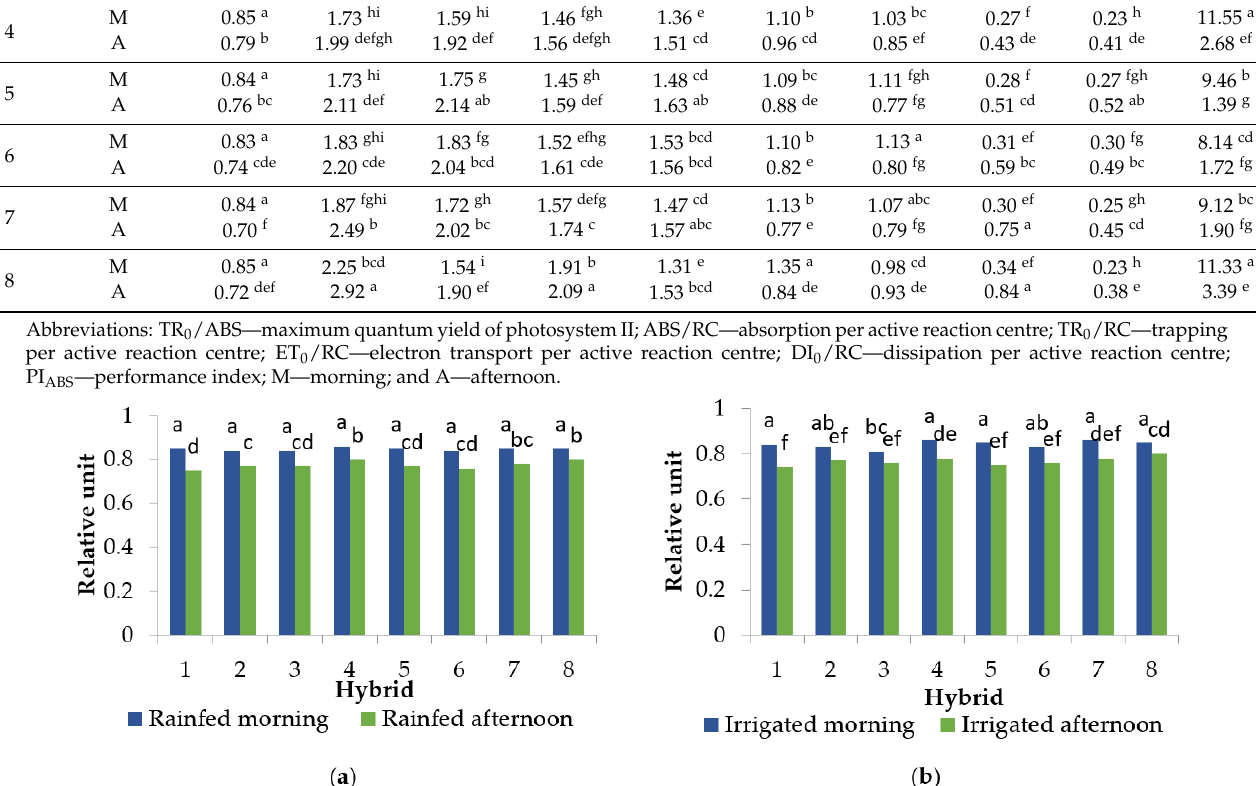
Figure 3. Mean values of the maximal quantum yield of photosystem II (TR 0 /ABS) in 2014 per hybrid depending on the treatments and the time of measurement: ( a ) rainfed in the morning and afternoon conditions, and ( b ) irrigated in the morning and afternoon conditions. Means with the same letter are not significantly different according to Tukey’s HSD test at p < 0.01. Table 1. Mean values of JIP-test parameters ( n = 24) for eight sunflower hybrids in the morning and afternoon conditions in 2013 and 2014. Means with the same letters in columns are not significantly different according to Tukey’s HSD